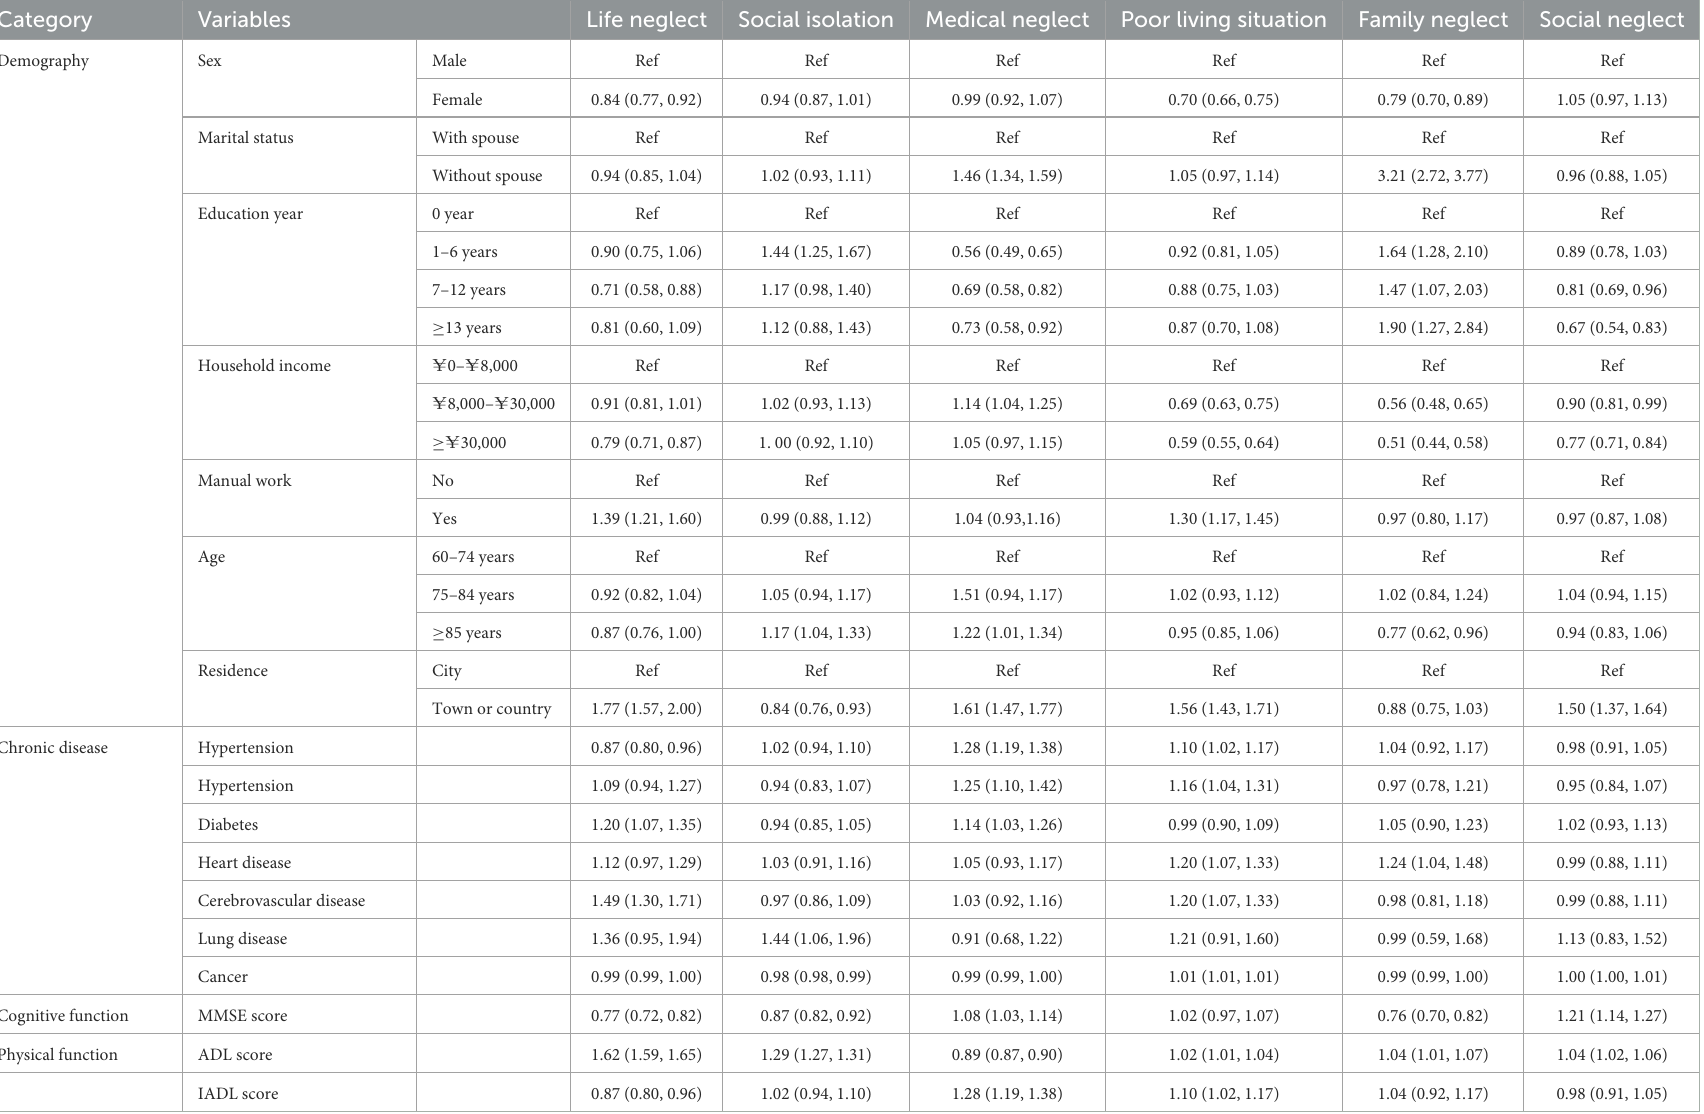
TABLE 3 Odds ratios (OR) and 95% confidence intervals of each characteristic of EN by multivariate logistic regression.